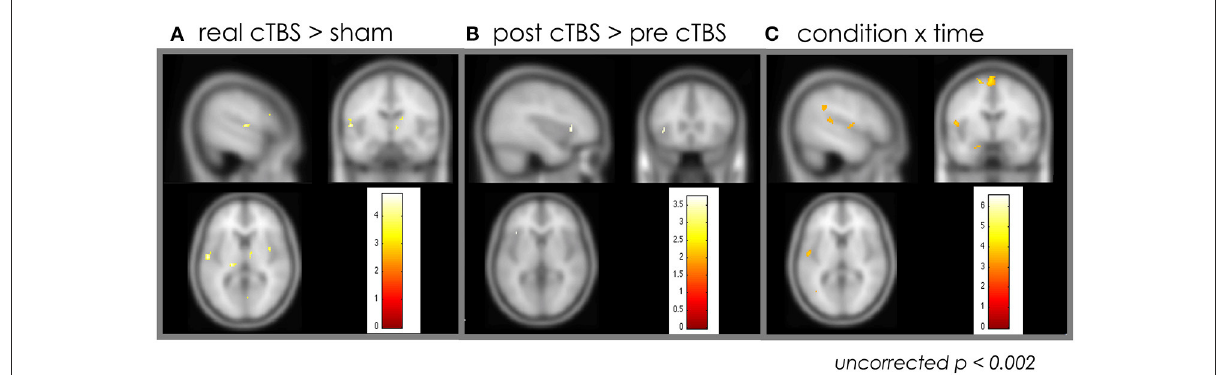
FIGURE2 Effect of the cTBS: whole brain analysis. (A) Increased activation in the right insula, right pIFG, left superior temporal gyrus, left middle temporal gyrus, and left middle frontal area in the real cTBS group compared to sham group. (B) The post-cTBS MRI showed significantly increased activation only in the left pIFG compared to pre-cTBS. (C) A significant interaction effect between condition and time was observed in the left pIFG, the left superior temporal gyrus, both superior parietal lobules, the left angular gyrus, and the left cuneus. cTBS, continuous theta-burst stimulation; pIFG, posterior inferior frontal gyrus; MRI, magnetic resonance imaging.